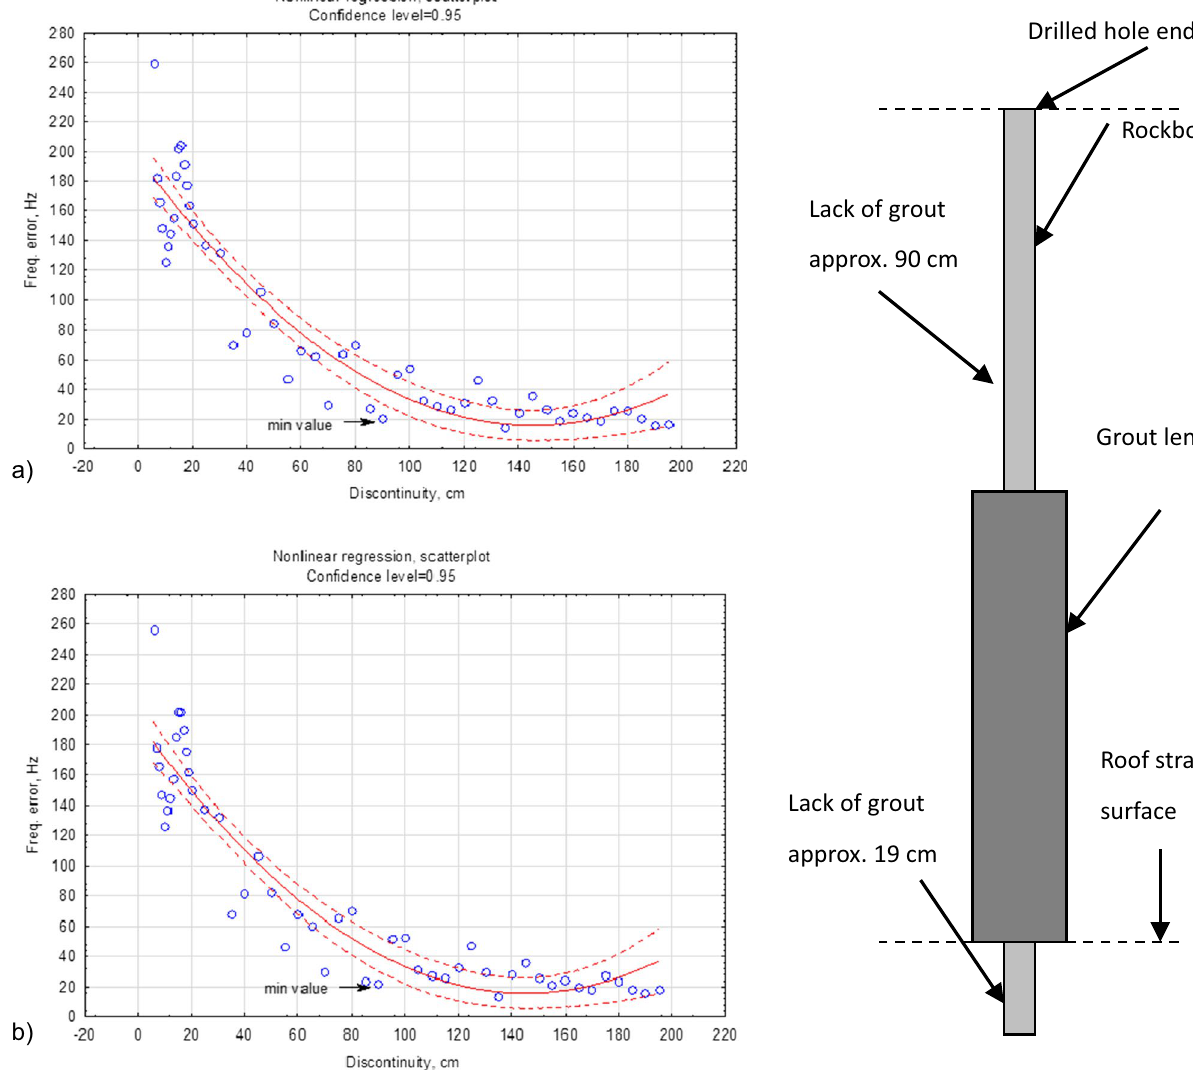
Fig. 8 Scatter plot of the differences between FE model and data evaluated experimentally (here for hidden, inner part only). The value of the length of discontinuity is specified for the first minimum differ- ences of models (experimental and theoretical). a For measurements